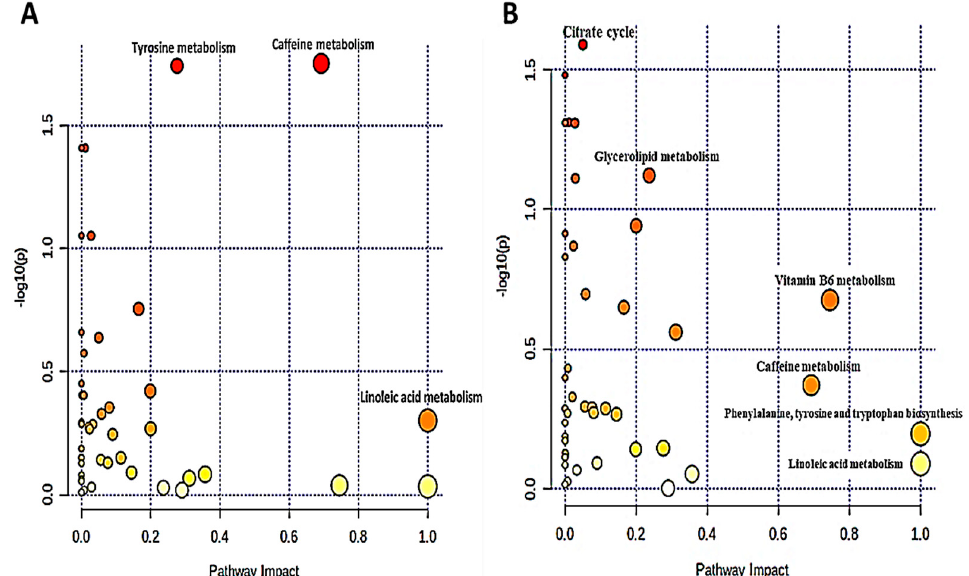
Figure 5. ( A ) Metabolic pathway analysis of clinically confirmed diabetic status; ( B ) metabolic pathway analysis based on latest HbA1c values. Each bubble in the bubble diagram represents a metabolic pathway. Color gradient and circle size indicate the significance of the pathway ranked by p -value (yellow: higher p -values and red: lower p -values) and pathway impact score (the larger the circle, the higher the pathway impact score). The top three metabolic pathways were identified by name according to the -log( p ) value and pathway impact score. Table 1. Analysis of the top metabolic pathways based on clinically confirmed diabetic status and latest HbA1c values.